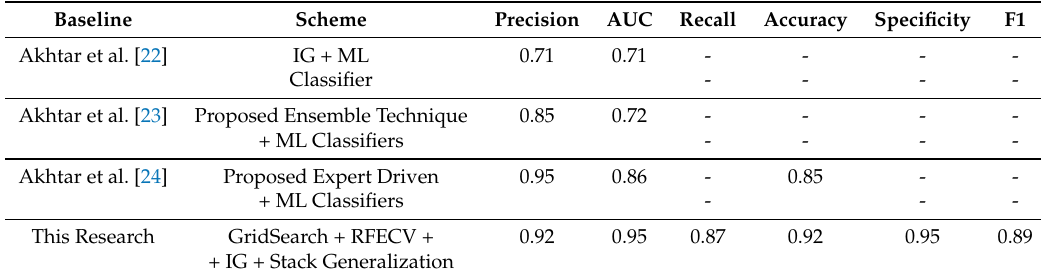
Table 5. Comparative best results of proposed and previously published schemes on the said Large for gestational age dataset.